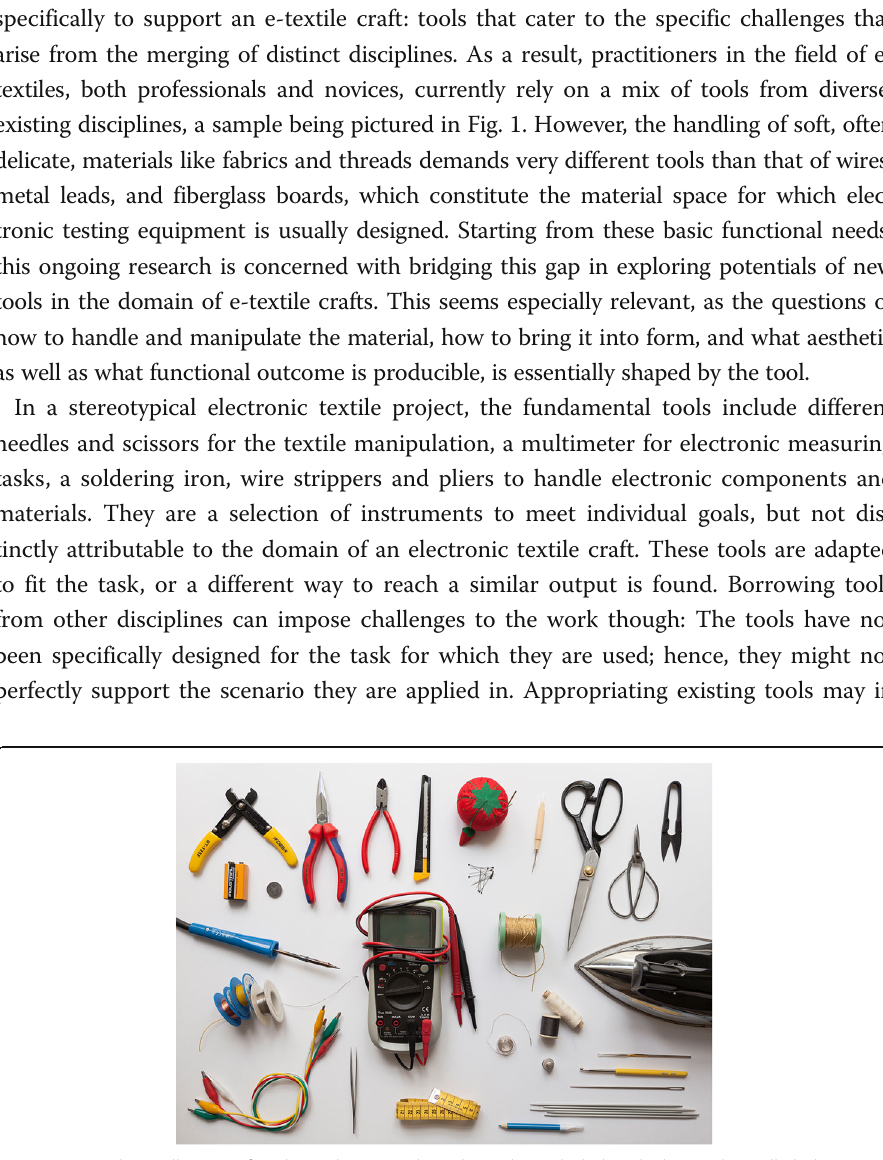
Fig. 1 Exemplary collection of tools used in e-textile making, the included tools that traditionally belong to the discipline of textiles or electronics, sometimes also to the jewelry and other related disciplines. In the center a multimeter with a pair of standard multimeter probes. A multimeter is essential to electronic measuring tasks, among others to measure resistances or detect short